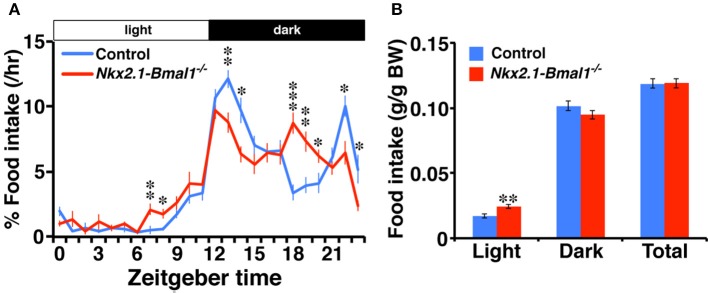
Temporal pattern of food intake during the dark phase is altered in Nkx2.1-Bmal1−/− mice. (A) Hourly plots of food intake, expressed as percentage of daily total. (B) Food intake per body weight during 12-h light phase (Light), 12-h dark phase (Dark), and 24-h day (Total). Values are mean ± SEM. n = 6 for control, n = 4 for Nkx2.1-Bmal1−/− mice. *p < 0.05; **p < 0.01; ***p < 0.001 by a Tukey-HSD post-hoc. The p-values calculated by two-way repeated measures ANOVAs are: (A) the effect of genotype, F(1, 529) > 1000, p < 0.001; the effect of time, F(23, 529) = 53.22, p < 0.001; and the interaction between genotype and time, F(23, 529) = 5.65, p < 0.001; (B) the effect of genotype, F(1, 23) = 0.003, p = 0.960; the effect of time (Light vs. Dark), F(1, 23) = 559.33, p < 0.001; and the interaction between genotype and time, F(1, 23) = 2.04, p = 0.026.